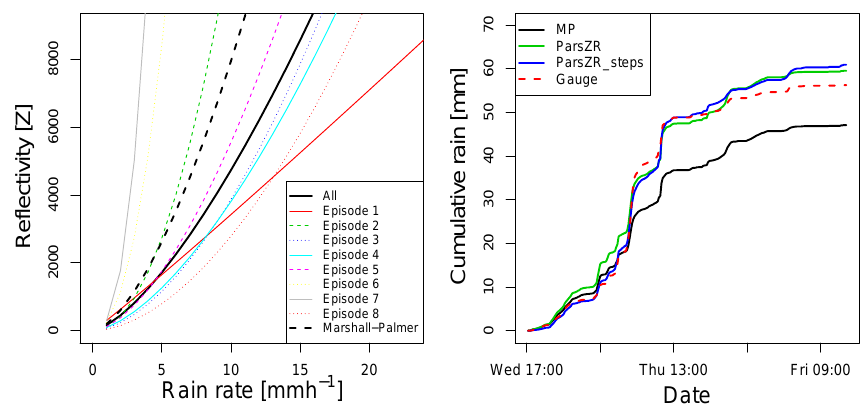
Figure 10. Left panel: all nonlinear fits together with the Marshall–Palmer Z – R relation. Right panel: accumulated rain for different Z – R relations applied to reflectivity data that are corrected for calibration, static clutter and wet-radome